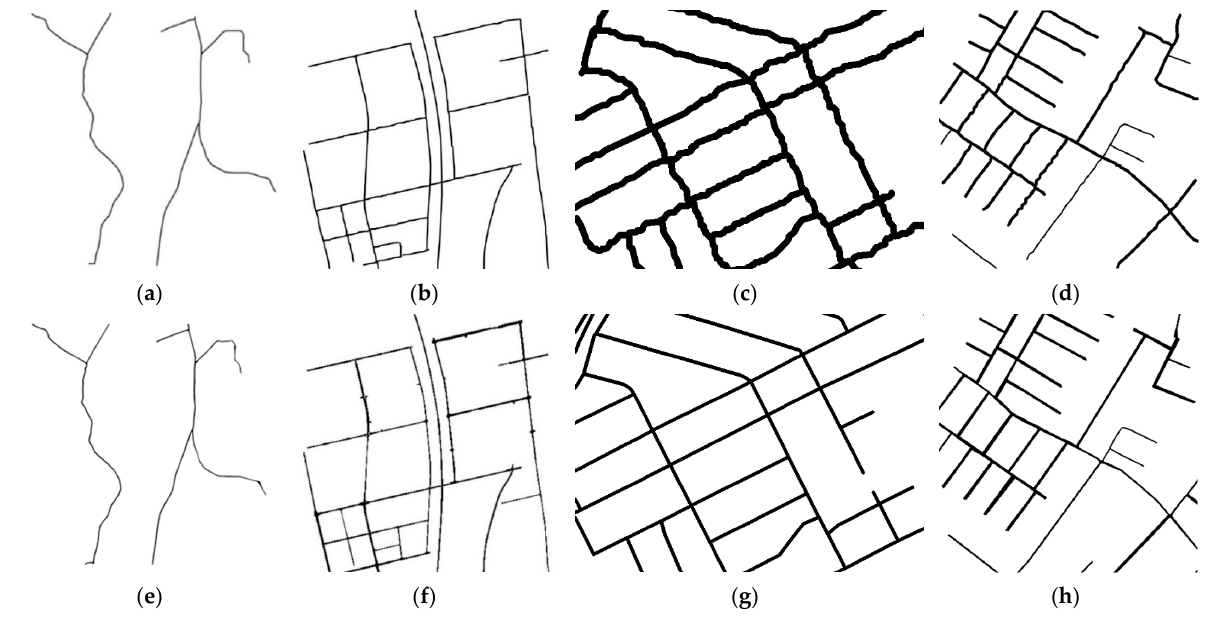
Figure 16. Comparison between the road extraction results and the ground truth: ( a – d ) are the road extraction results and ( e – h ) are the ground truth. Table 1. Evaluation table of road extraction.